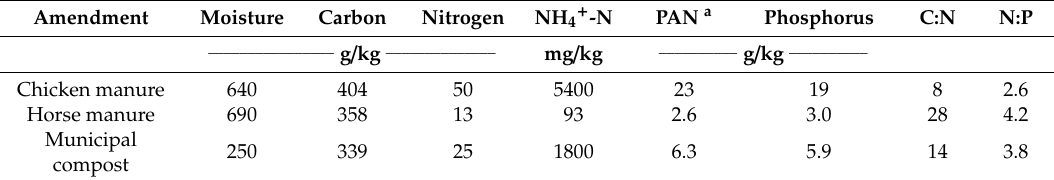
Table 1. Nutrient content (expressed as dry weight) of amendments used in the current study, where PAN = estimated plant-available nitrogen.